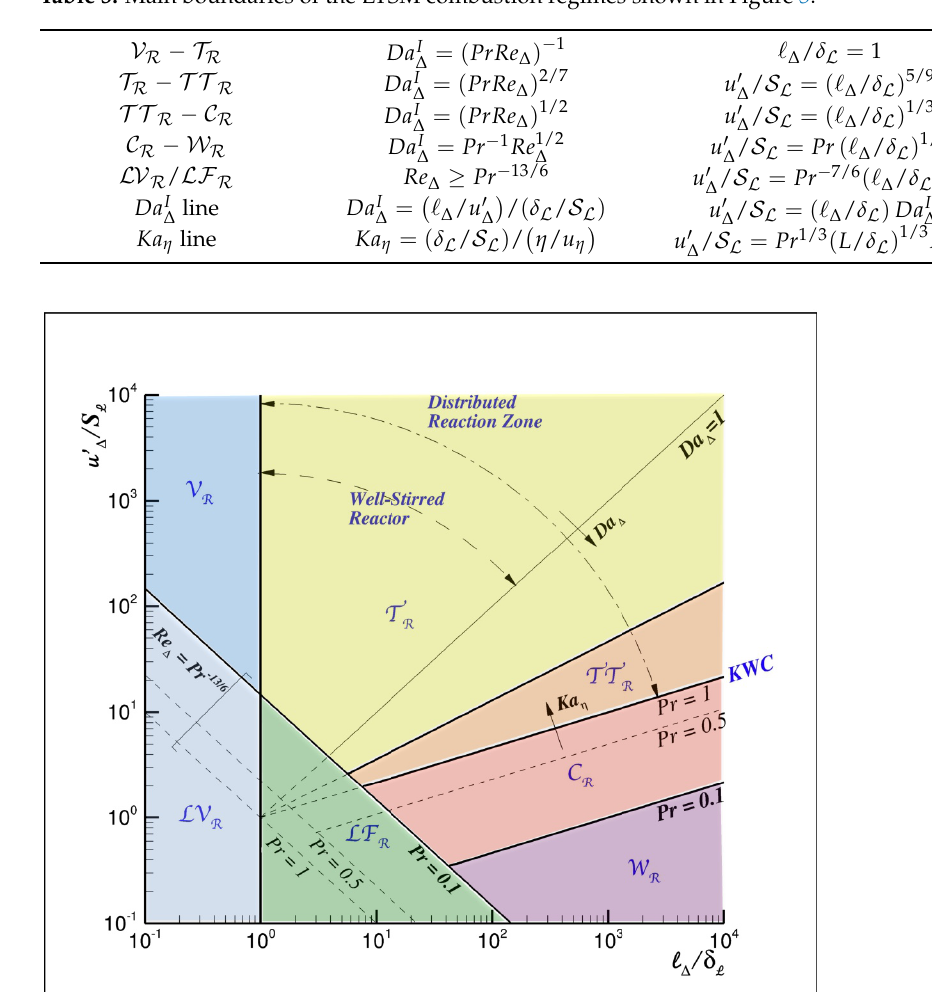
Figure 5. Combustion regime identification according to the LTSM framework for 1 ≥ Pr ≥ Re − 6/13 ∆ : (top) u (cid:48) ∆ / S L vs . (cid:96) ∆ / δ L plane; (bottom) Da ∆ vs . Pr ∆ Re ∆